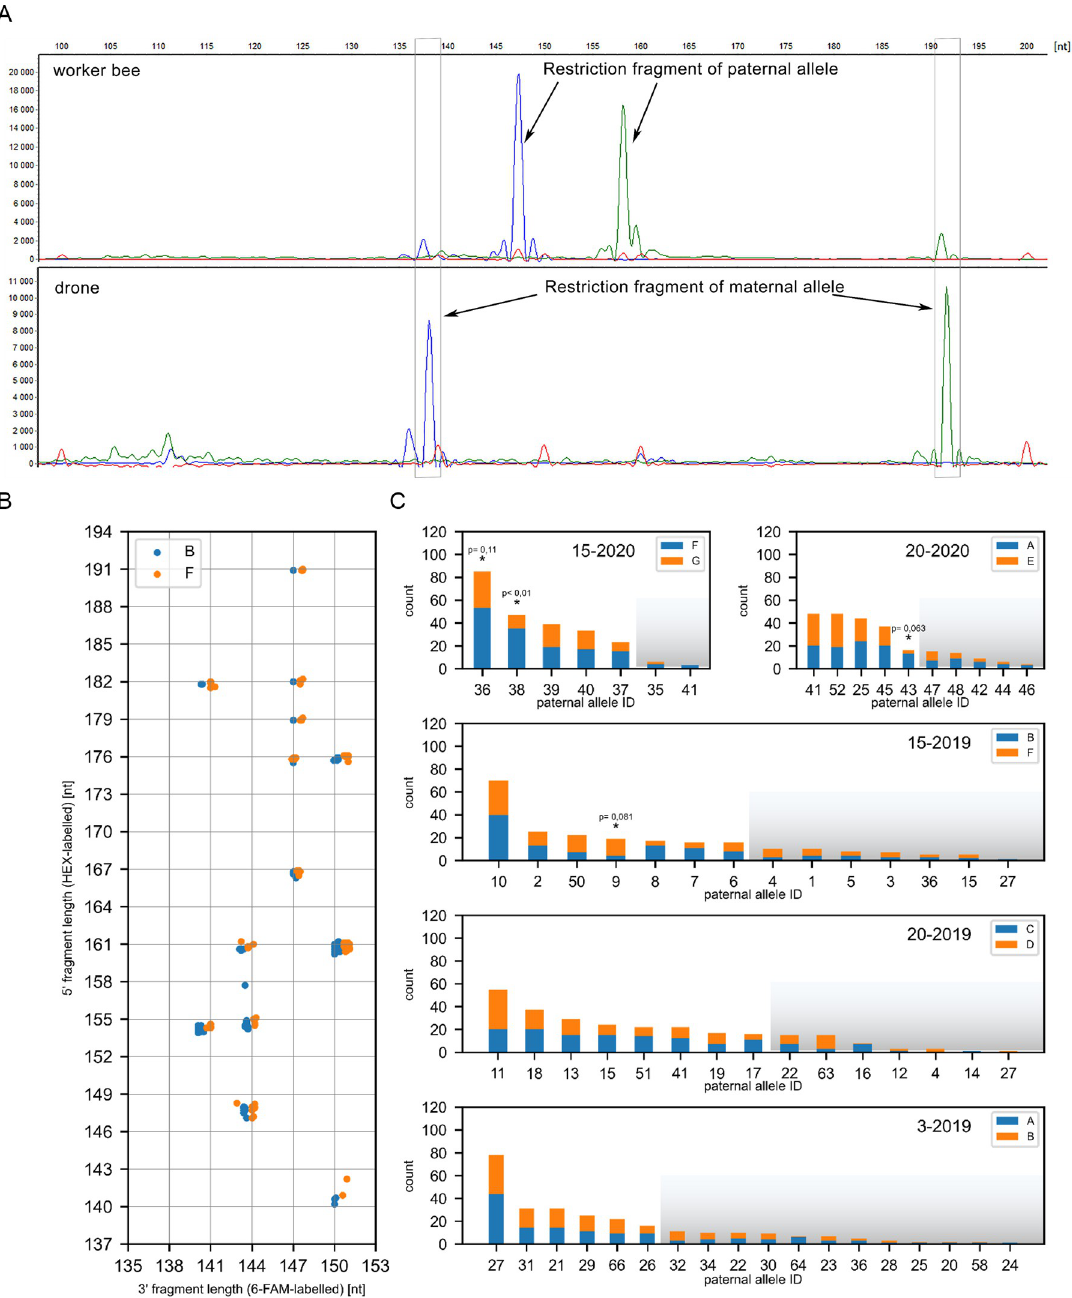
Fig 3. Terminal restriction fragment length polymorphism method of identifying paternal csd alleles in bee colonies. (A) An example of T-RFLP analysis of a drone (maternal allele) and a worker bee (identification of a paternal allele) csd alleles. (B) An example of the distribution of the paternal alleles based on the length of the VspI restriction fragments of analysed portion of the csd gene assessed by the T-RFLP method (colony 15–2019). Blue and orange dots represent paternal alleles paired with a given maternal alleles. (C) Frequency of the occurrence of the paternal alleles in each colony and the distribution of the maternal alleles (blue and orange bars) in each csd patriline. Paternal allele groups with statistically significant (chi-test with Bonferroni correction for multiple testing, p < 0.1) differences in pairing with maternal alleles are marked with asterisk. Shaded parts of the graph indicate patrilines that were excluded from the analysis due to too small number of individuals in a given patriline.